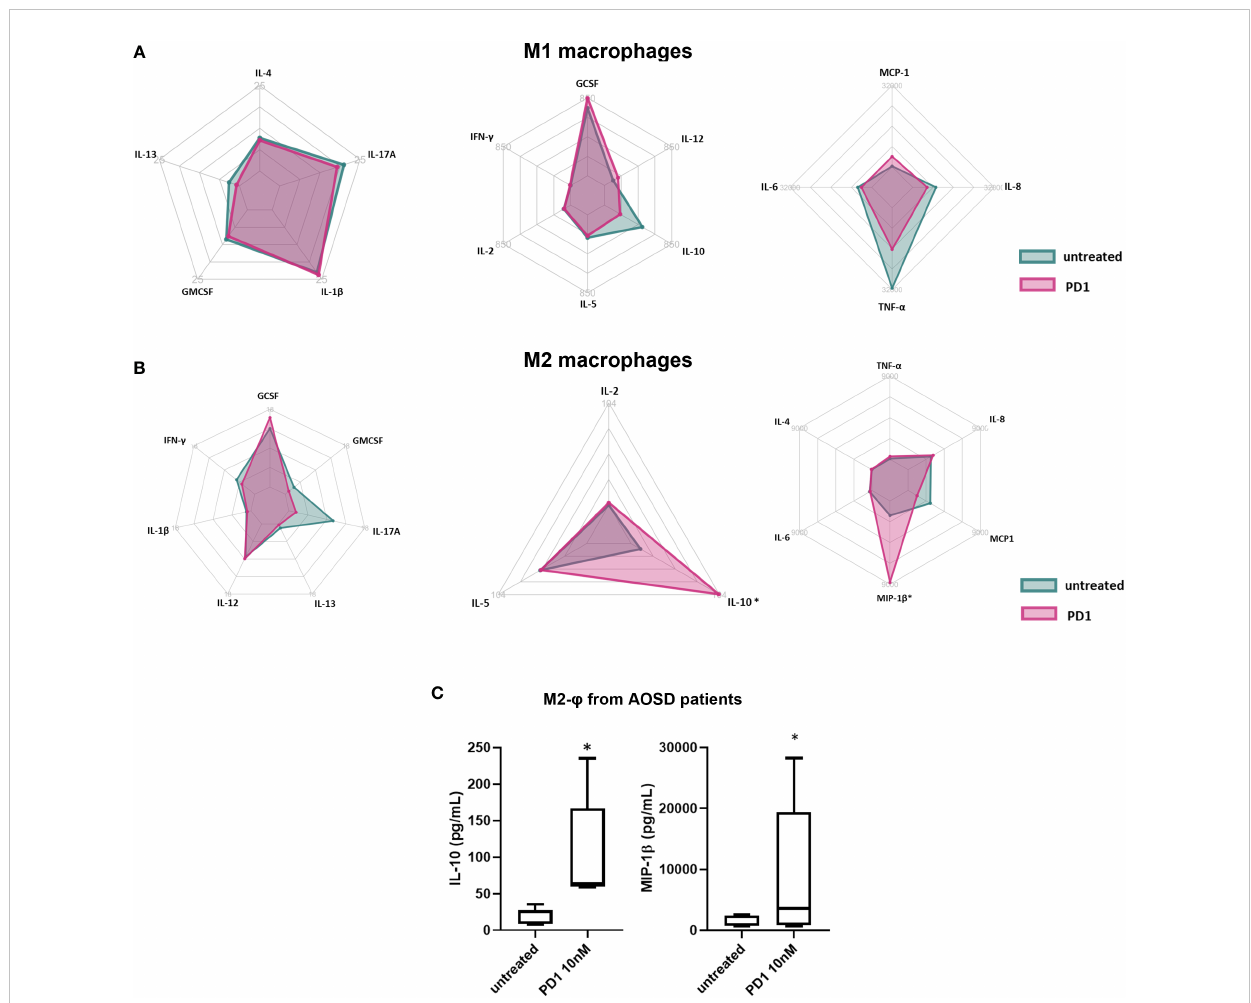
FIGURE 5 Effect of PD1 on secretion of cytokines/chemokines by macrophages from AOSD patients. Radar chart summarizing cytokines and chemokines pro fi le of M1 (A) and M2 (B) macrophages from COVID-19 patients after in vitro treatment with PD1. Green plot represents untreated cells, while red plot PD1-treated cells. (C) Multiplex analysis of IL-10 and MIP-1 b levels in supernatants of M2 macrophages from AOSD patients (n = 10) treated with PD1. Data are reported as pg/mL. IL-10, untreated vs PD1, *p= 0.03; MIP-1 b , untreated vs PD1, *p= 0.03.